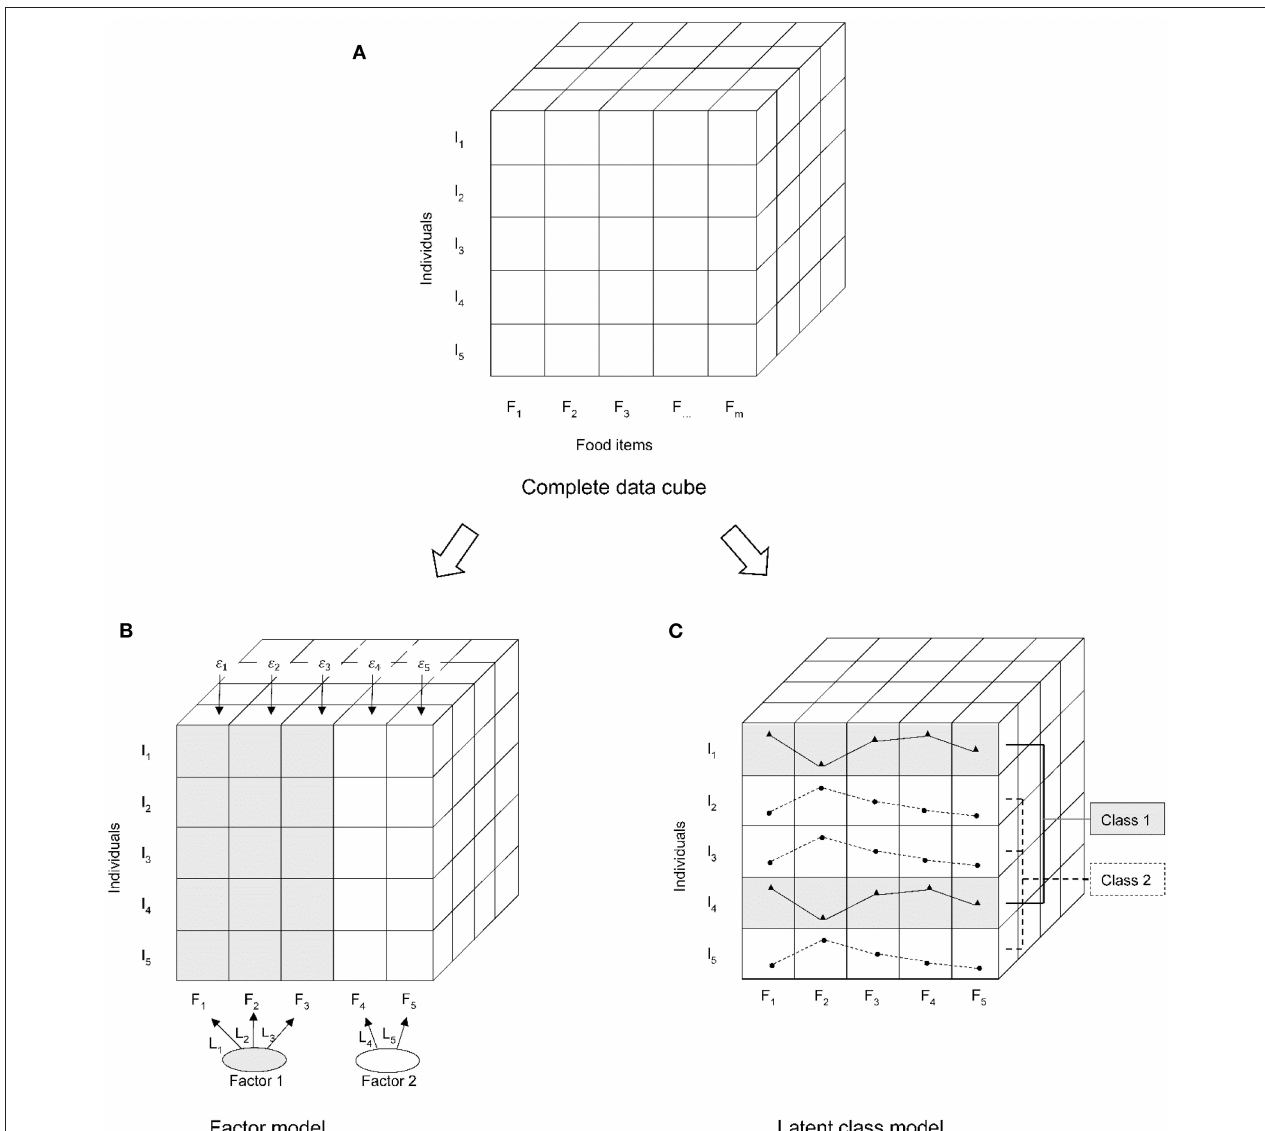
FIGURE 1 | Differences in technical processing between the latent class analysis (LCA) and factor analysis (FA). (A) Data structure; (B) FA is a variable-oriented data reduction technique; (C) LCA is a person-centered classification technique. I, individuals; F, food items.